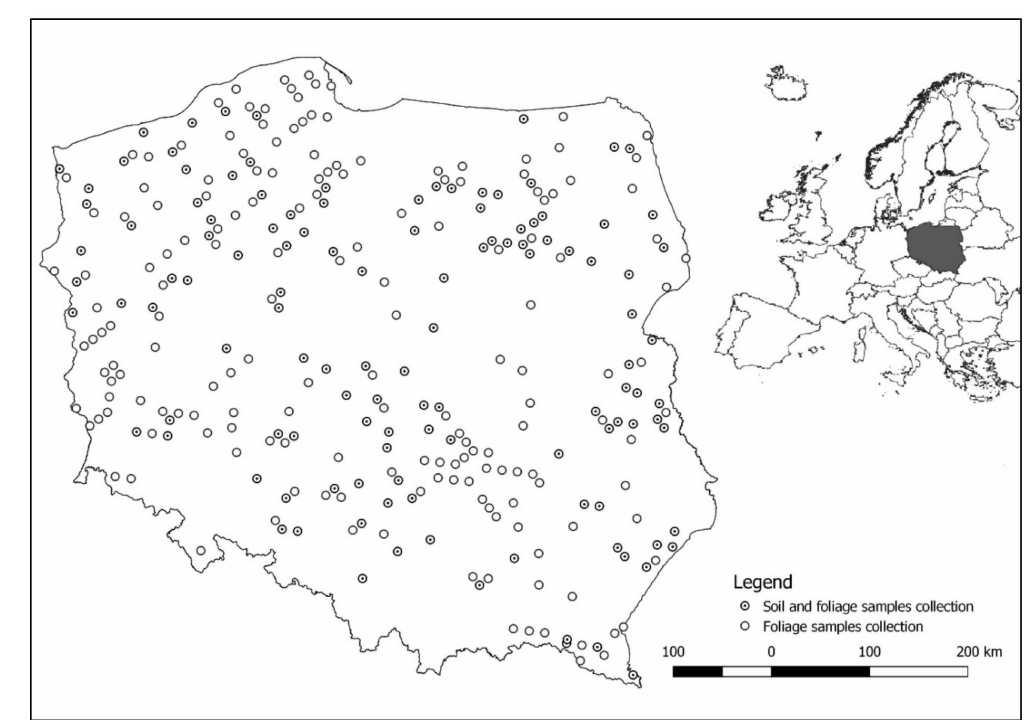
Figure 1. Location of monitoring plots for sampling of soil and Scots pine